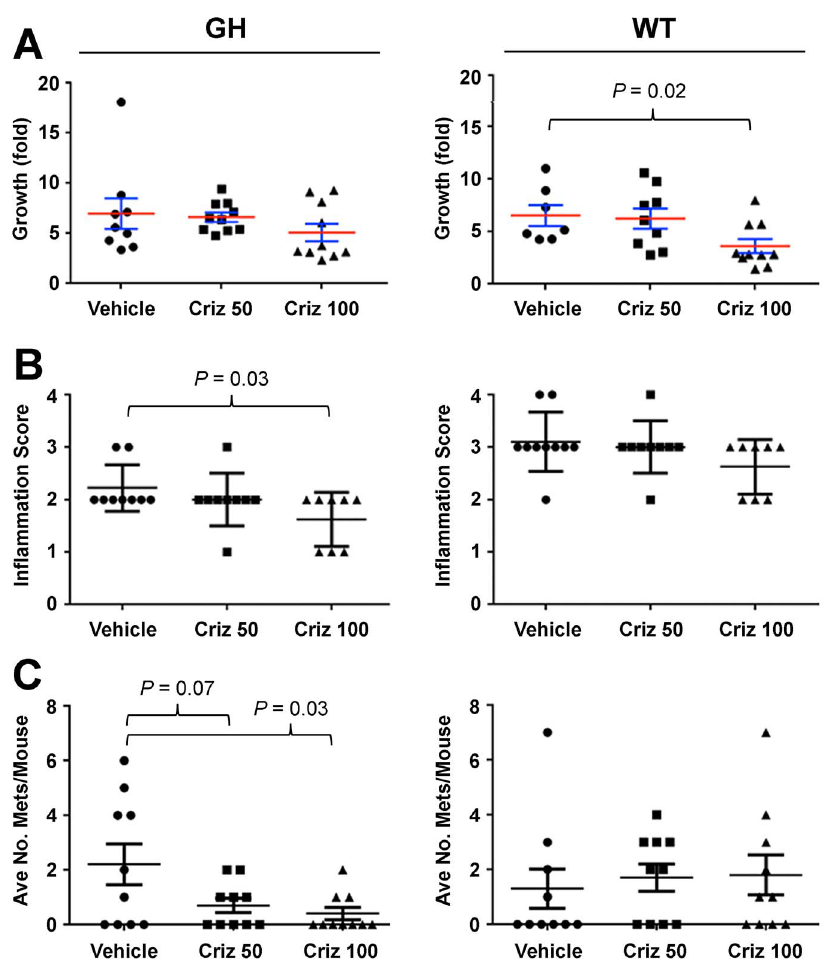
Figure 5. Immunogenicity of ffLuc-eGFP alters the response of tumors, including metastases, to targeted therapy in wildtype mice compared to GH mice. Labeled melanoma tissues from the HGF/CDK4 R24C -transgenic mouse [18] were subcutaneously inoculated into WT and GH c-Brd mice. When the average tumor size reached 125 mm 3 , mice from each strain were randomized into two groups to receive either control vehicle (saline) or the MET inhibitor crizotinib (Criz). Tumor size was measured periodically. A , Fold-tumor growth in WT and GH c-Brd mice (mean 6 SE). 100 mg/kg Criz treatment delayed tumor growth in WT mice (right panel, P , 0.02 in two-tailed T-test), but no efficacy was found in GH mice (left panel). B , When primary tumors reached 2000 mm 3 , the mice were euthanized to harvest tumors and lungs. Tumors were subjected to pathological analysis of inflammatory infiltrates according to the scoring system: minimal =1, mild =2, moderate =3, severe =4. Criz at 100 mg/kg significantly reduced inflammatory infiltration of the primary tumors in GH mice (left panel), but not in WT mice (right panel). C , The fixed lungs were subjected to the quantitation of metastatic foci. Criz reduced the number of pulmonary metastases in GH mice in a dose-dependent manner (left panel), but had no effect in WT mice (right